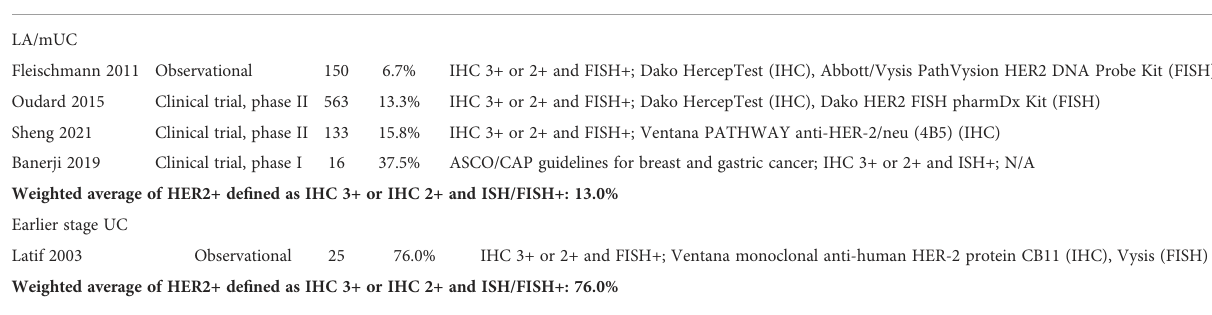
TABLE 1 Overview of HER2+.